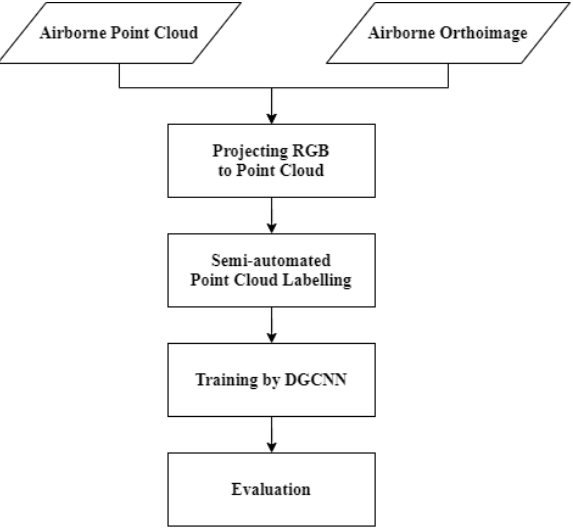
Figure 2. The methodological